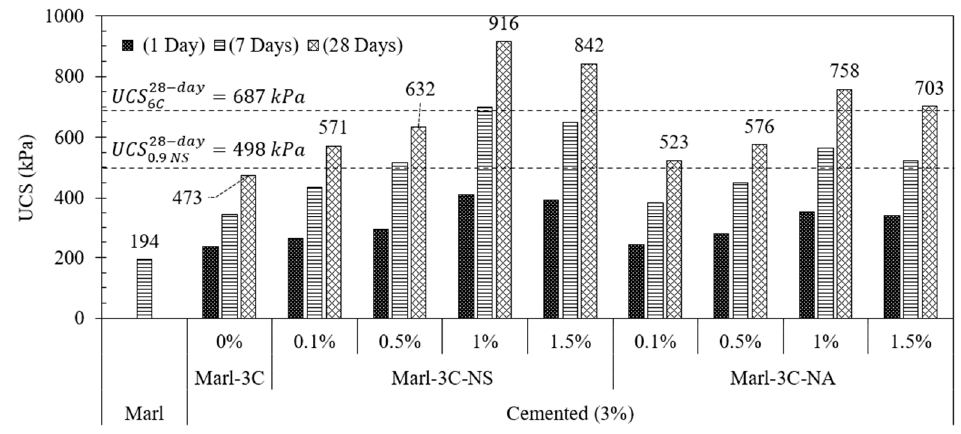
Figure 3. Unconfined compressive strength of stabilized marl.